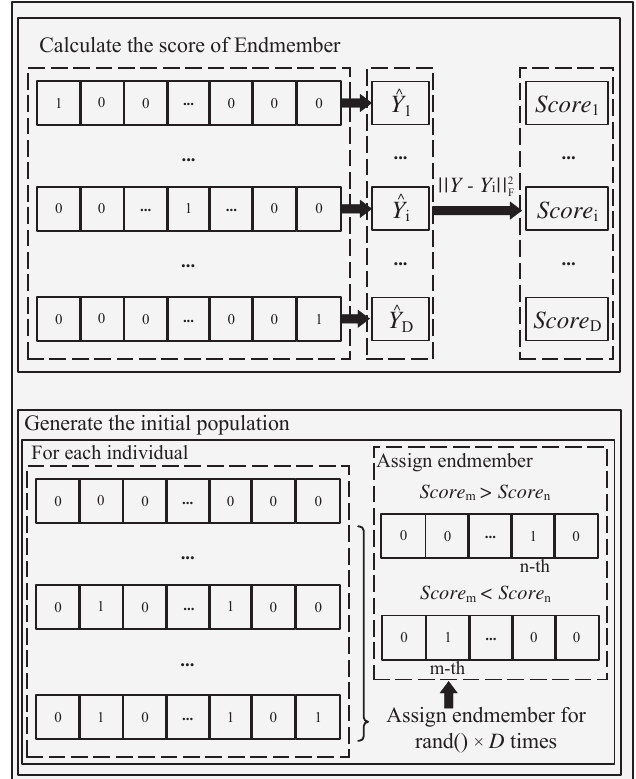
Figure 2. Obtaining the score of every endmember and generate the initial